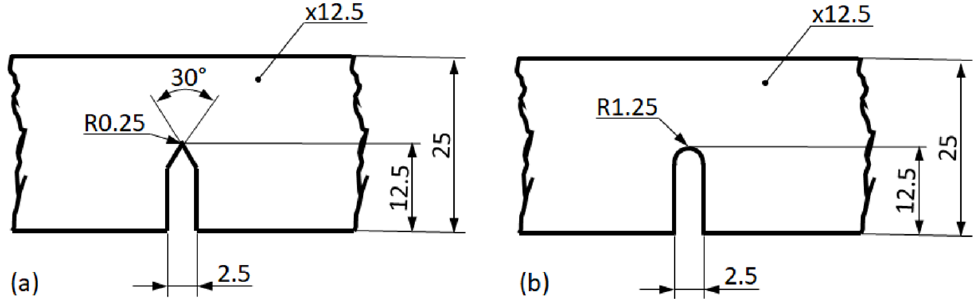
Figure 1. The investigated notch geometries: ( a ) sharp notch; ( b ) blunt notch.